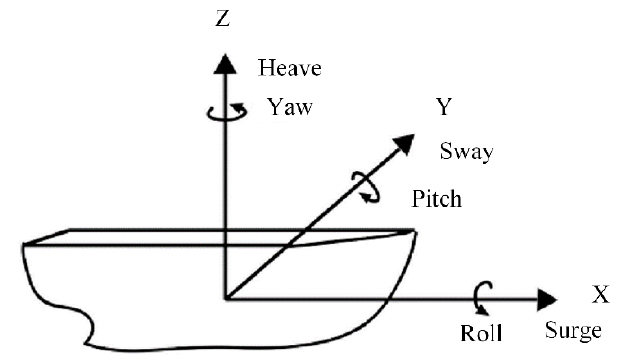
Figure 1. Six-degrees-freedom motions of the vessel.